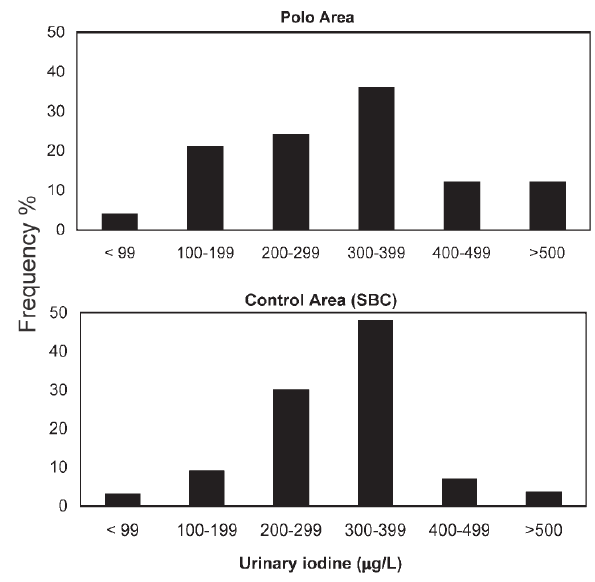
Figure 1 - The relative (%) frequency of “spot” urinary samples iodine in the two populations studied. Note that in both areas, about 4% of the population had values of less than 100 μ g Iodine/L. The median values were, respectively 305.0 μ g Iodine/L (Polo Area) and 306.8 μ g Iodine/L (São Bernardo Campo Area). Of all the people tested in both communities, 58.5% had values of more than 300 μ g I/L of Table 1 - Prevalence of chronic autoimmune thyroiditis in two distinct areas of São Paulo, Brazil.